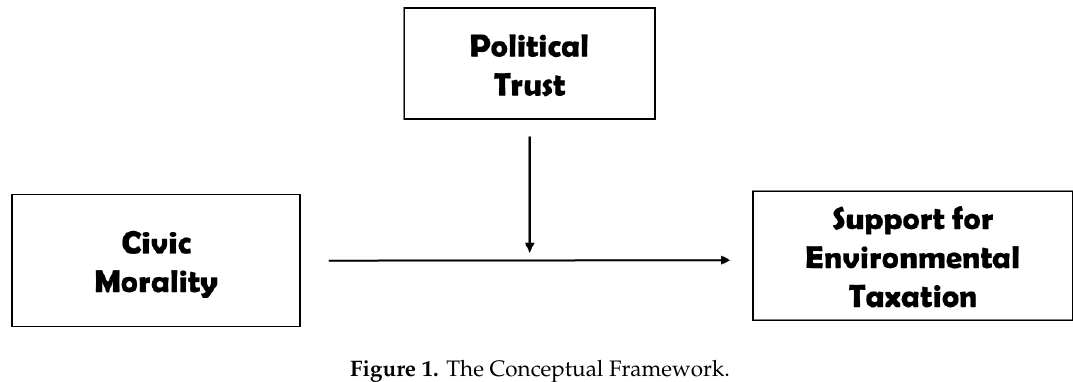
Figure 1. The Conceptual Framework.